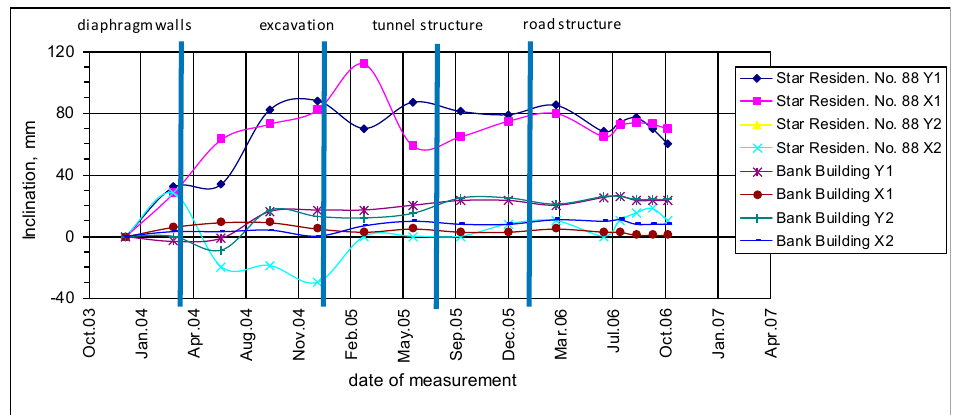
Figure 15. Inclination of selected objects (construction of the tunnel under the roundabout in Katowice—objects with small inclinations).